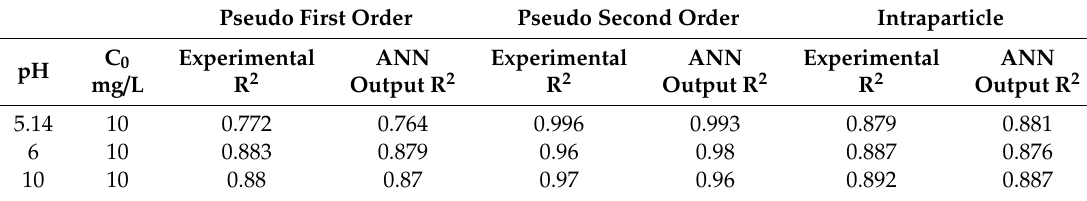
Figure 8. Kinetics study (Pseudo second-order model) at different pH values. Table 2. Adsorption kinetics constants and correlation coefficient for each model.